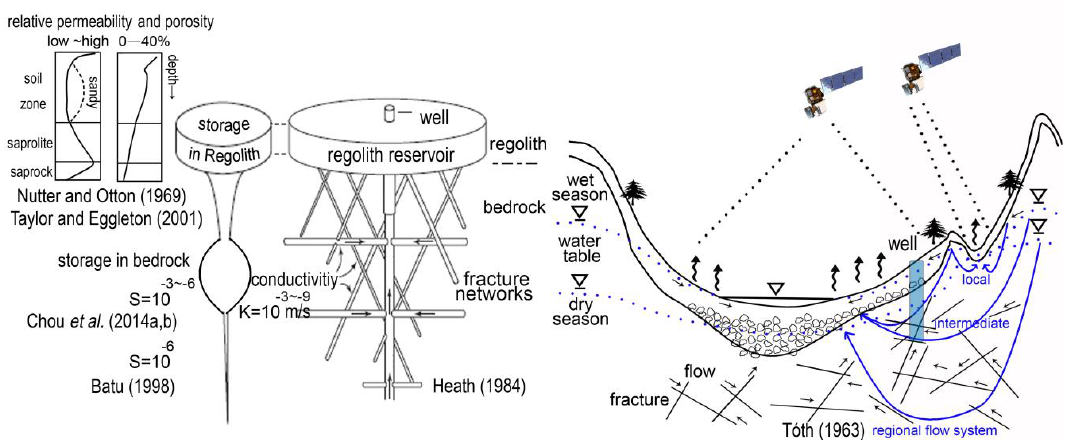
Figure 2. Hydrogeological characteristics of mountainous regions and illustration of groundwater exploration using remote sensing.